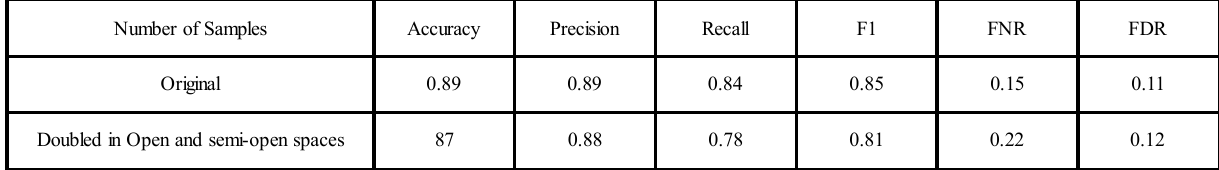
TABLE 7. PERFORMANCE MEASURES WITH INCREASING RSSI SAMPLES